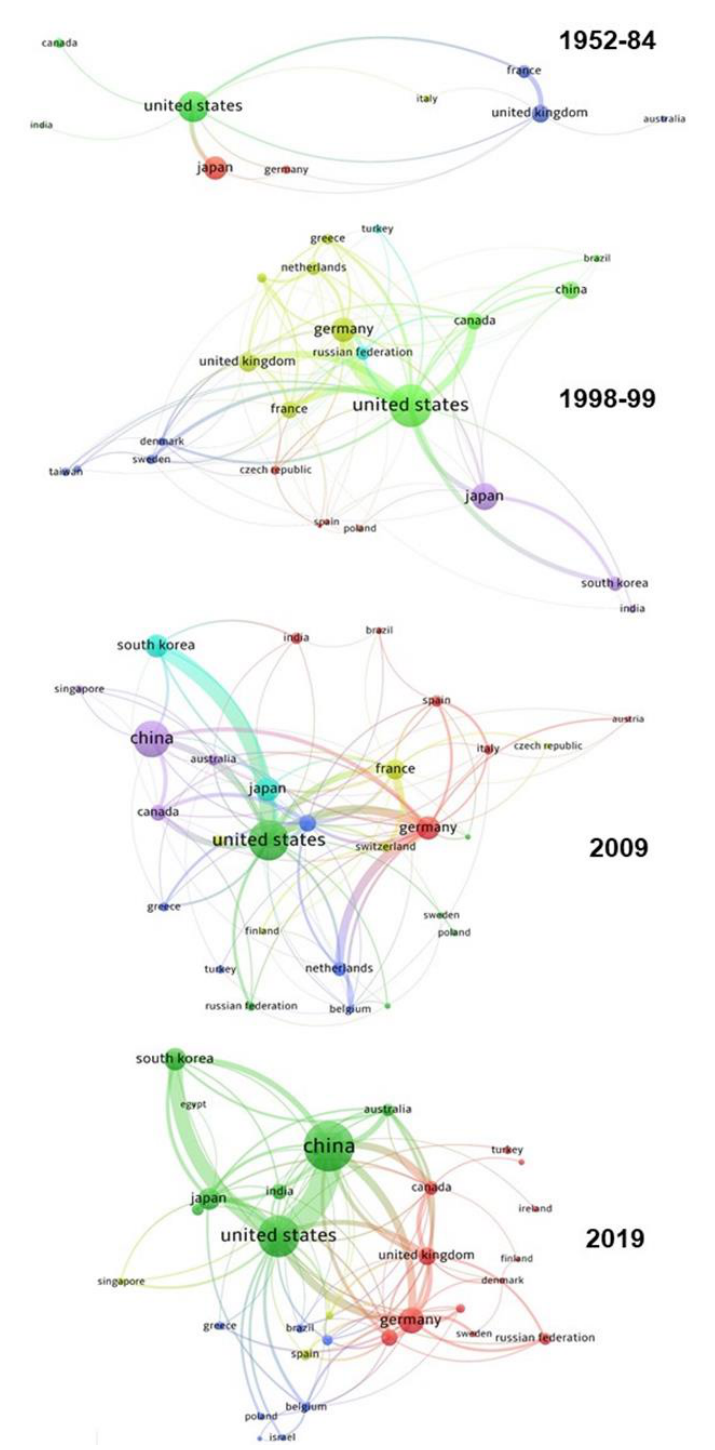
Figure 7. Evolution of the communities of countries and their associations in publications on block copolymers, in the period 1952 – 1984, 1998 – 1999, and during the years 2009 and 2019. Only countries with at least 10 documents and 5 overall links are shown, except for the period 1952 – 1984 where the threshold is just one link.